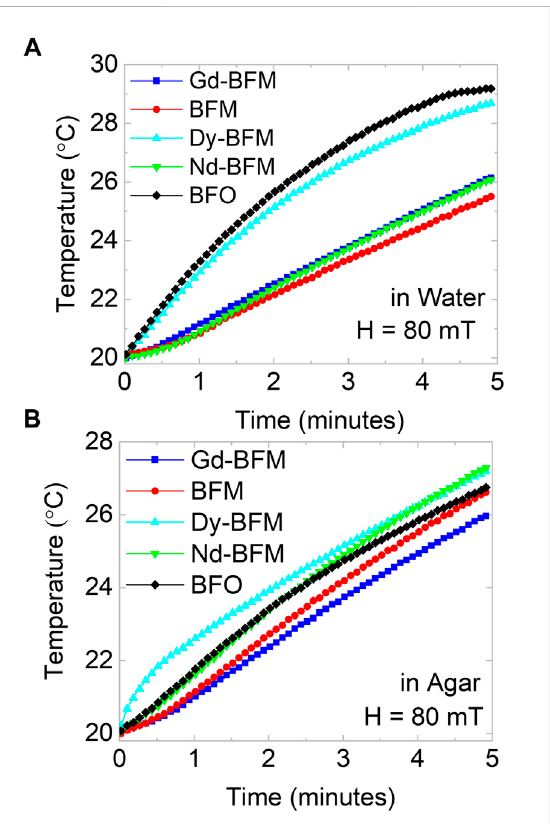
FIGURE 7 Hyperthermia tests of BFO and RE-Mn co-doped BFO NPs, the change in temperature due to applied AC fi eld of 80 mT, in water (A) , and in agar (B)